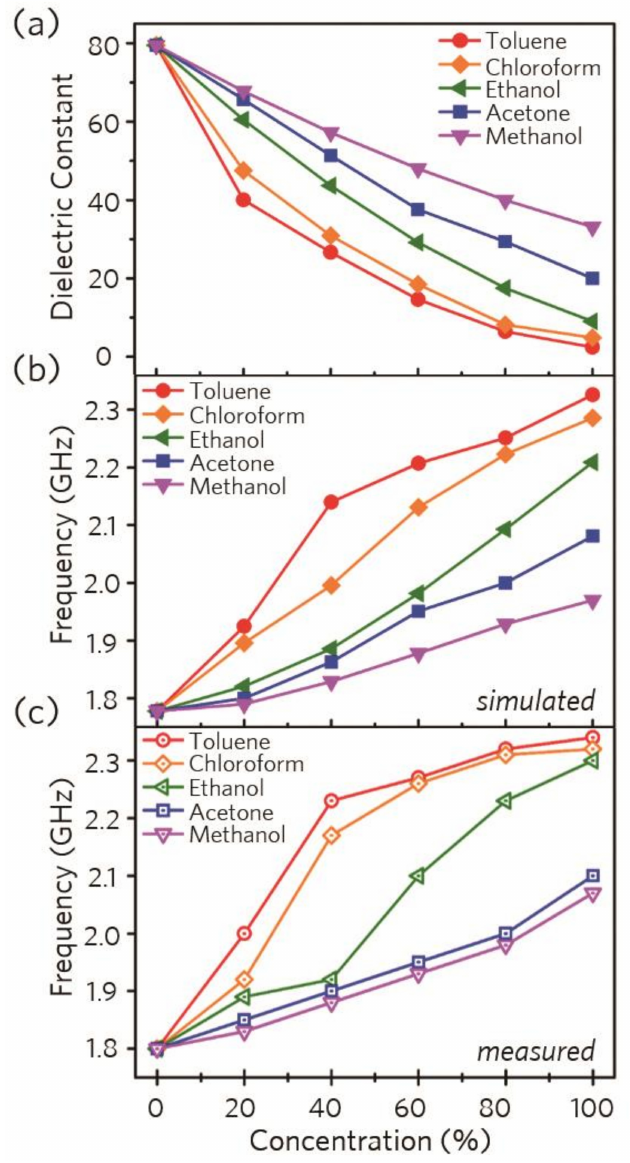
Figure 4. ( a ) Calculated effective dielectric constants for the chemical mixtures. ( b ) Simulated and ( c ) measured resonance frequencies for the chemical